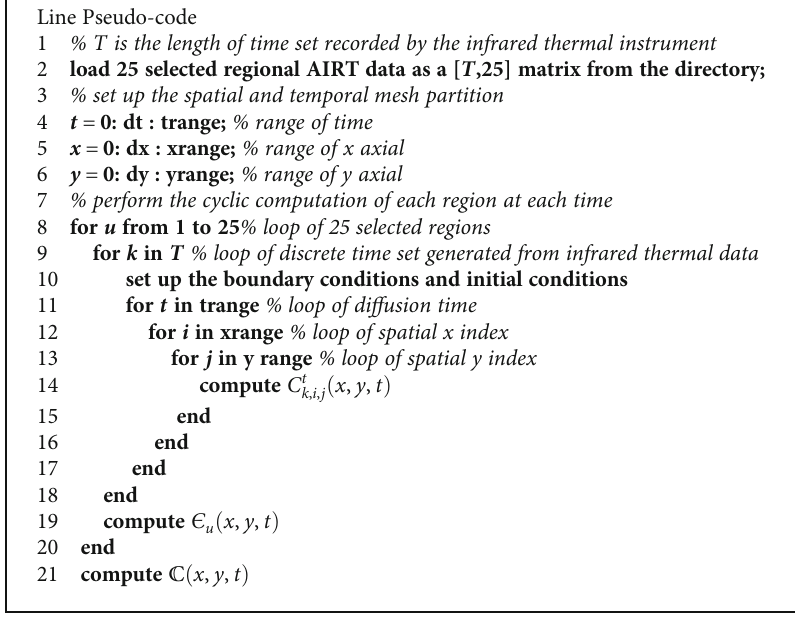
Pseudocode 1: MATLAB